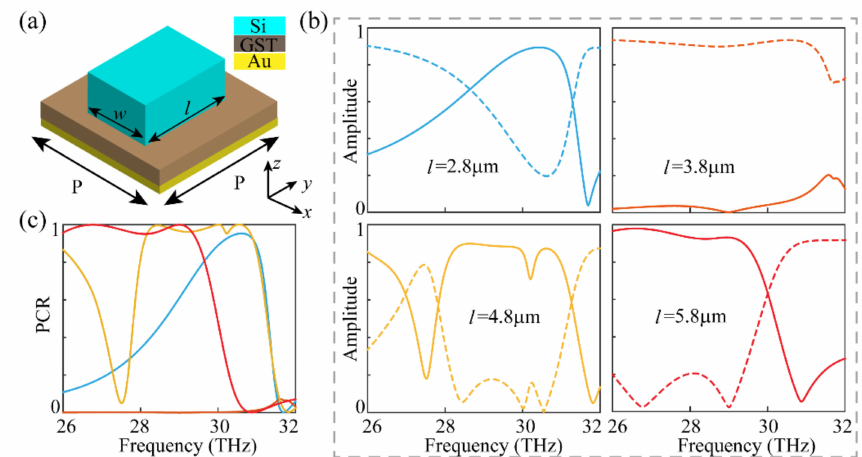
Figure 5. The design and performance with different geometric parameters. ( a ) The schematic diagram of the unit cell. P, w, and the thicknesses of the materials are the same as those in Figure 2a. ( b ) Simulated reflected amplitudes with different values of l . The solid and dotted lines are the cross- and co-polarized results respectively. ( c ) Corresponding PCR with different values of l